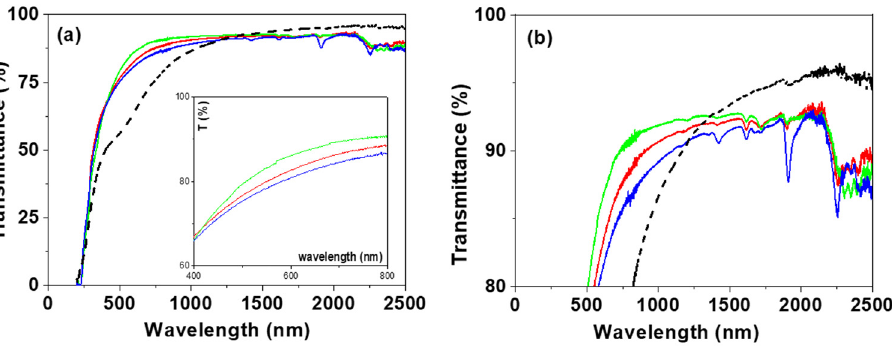
Figure 5. Light transmission versus wavelength for: ( a ) BMIMPF 6 /NPAS (red solid line), OMIMPF 6 /NPAS (green solid line) and EMIMBF 4 /NPAS (blue solid line) samples as well as the NPAS support (black dashed line); insert corresponds to visible region. ( b ) Enlargement of the transmission–wavelength curves. Table 5. Transmittance percentage at specific wavelength values for the IL/NPAS samples .